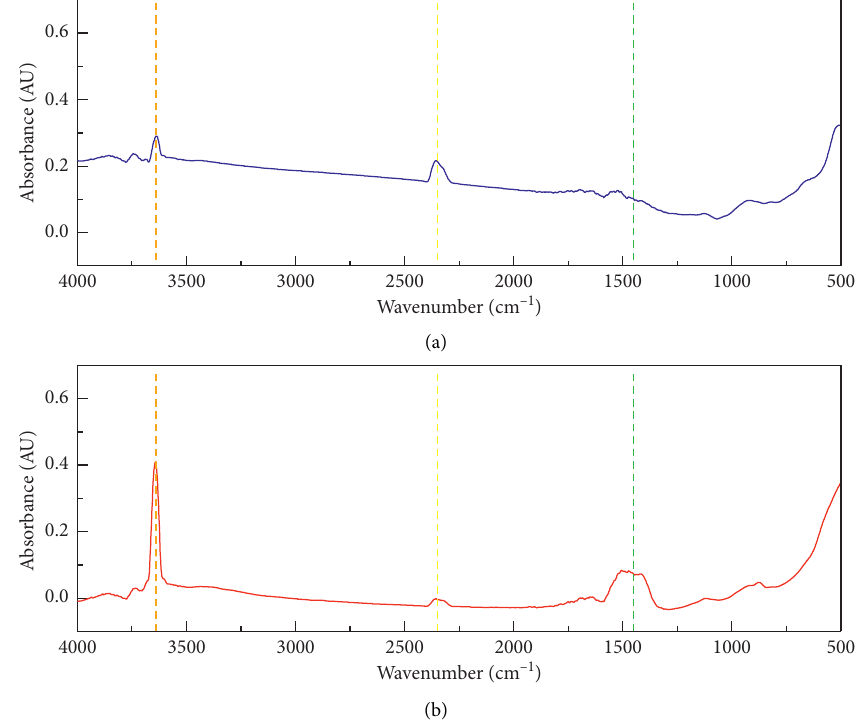
Figure 7: Gas chromatographic analysis of coal samples under static blasting.